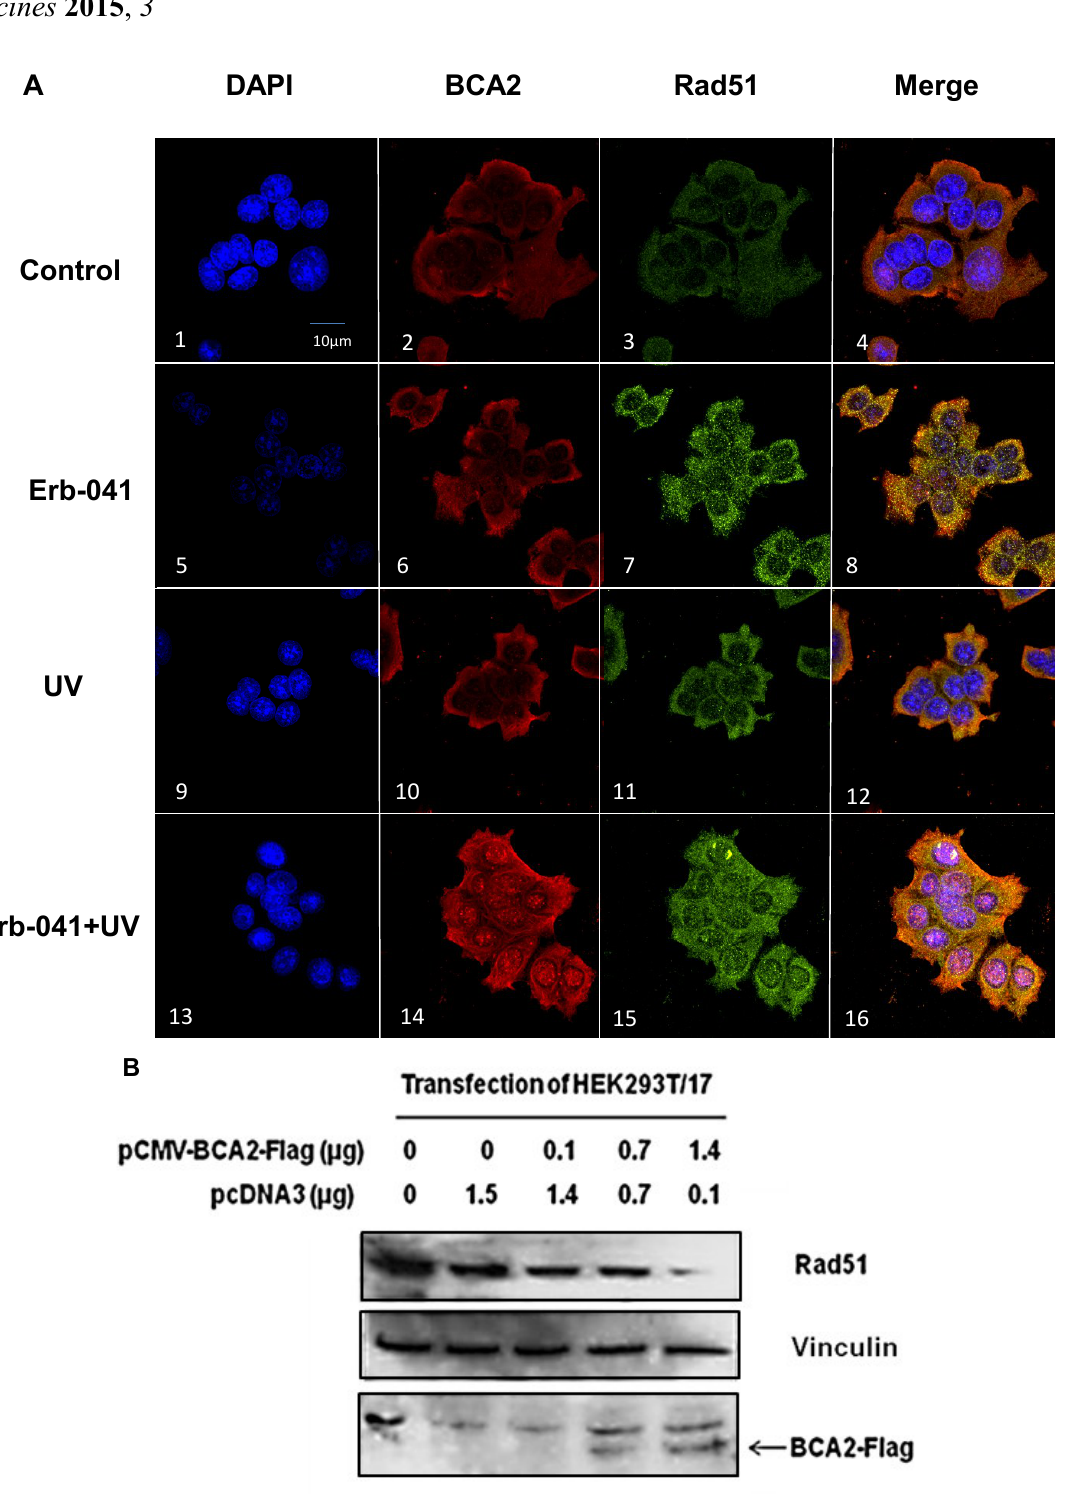
Figure 6. Erb-041 potentiated BCA2 and Rad51 nuclear co-localization in association with ubiquitin-mediated Rad51 degradation. ( A ) MCF-7 cells under different experimental conditions were fixed and immunostained with anti-BCA2 and Rad51 antibodies prior the staining with Alexa Fluor 488 anti-goat, Alexa Fluor 555 anti-rabbit IgG, and the nuclear stain, DAPI, for confocal microscopic imaging; ( B ) The pCMV-BCA2-Flag or pcDNA3 vector was transfected into HEK293T/17 cells. The cells were lysed 48 hours later, and the cell lysates were subject to SDS-PAGE and immunoblotting with anti-Rad51, actin